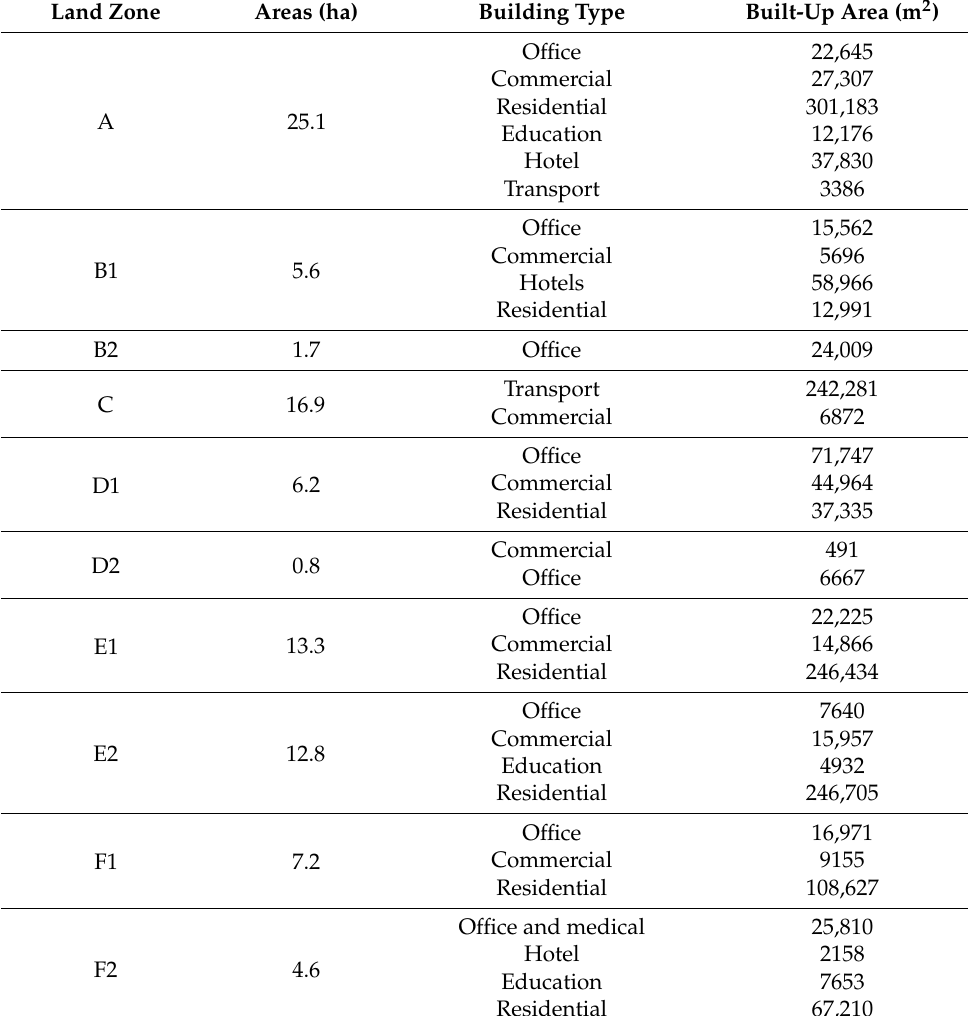
Table 4. Built-up area of individual block